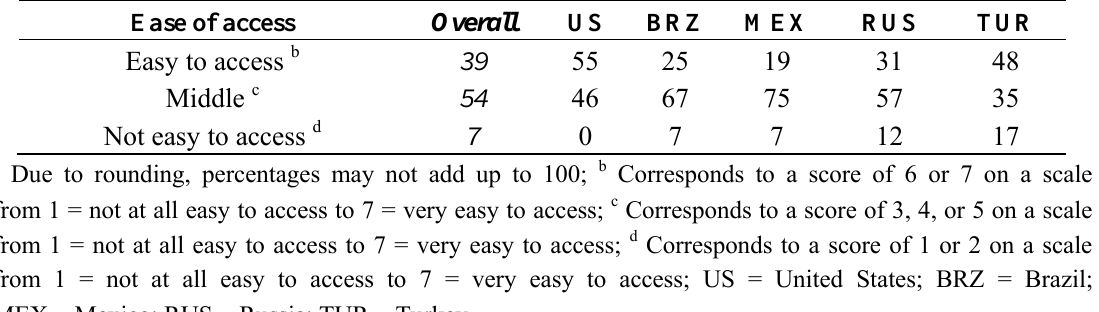
Table 2. Ease of access to rituximab (% of all physicians) a